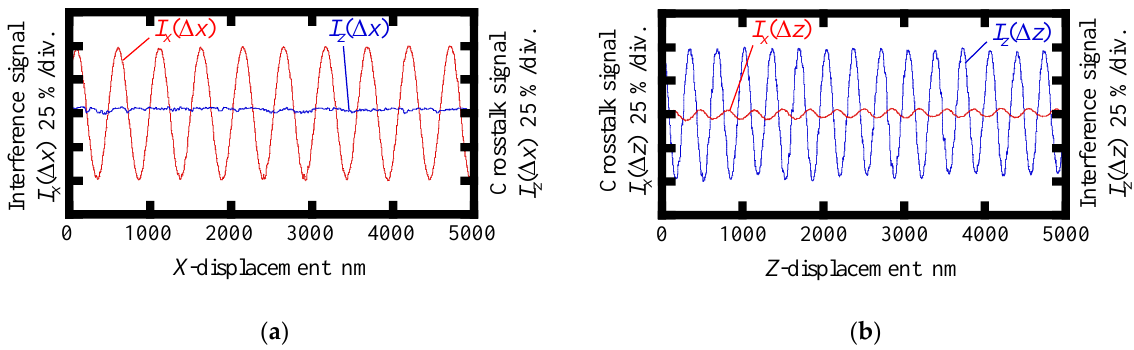
Figure 6. Interference signal and corresponding crosstalk signal observed in the conventional surface encoder: ( a ) Readouts of I x and I z when giving the X -displacement; ( b ) Readouts of I x and I z when giving the Z -displacement.